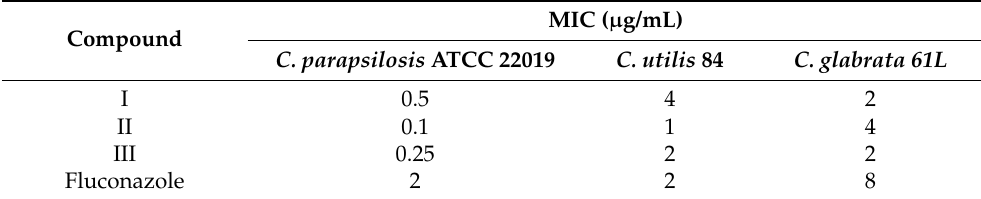
Table 1. Antifungal activity data of the hybrid compounds.